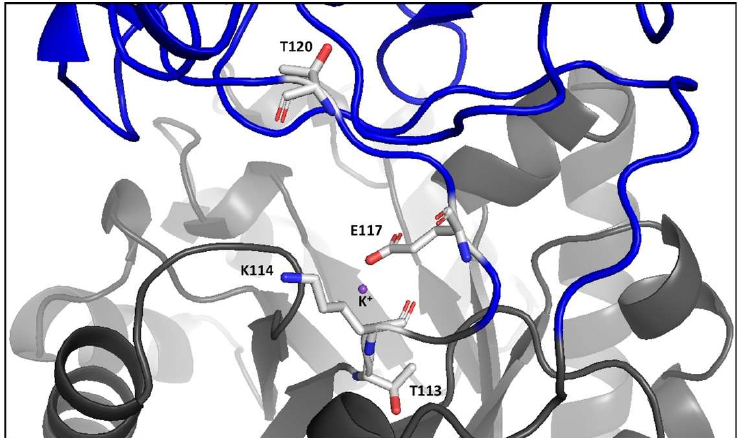
Figure 1. Ribbon representation of the boundary region between domains A (gray) and B (blue) of WT-RMPK. According to Oria-Hernández et al. (2006) [16], short loop residues T113, K114, E117, and T120 co-evolve in a consensus sequence in the family of the K + -dependent PKs in 80% of the 121 sequences; whereas L113, Q114, K117 and (L, V, I) 120 co-evolve in the K + -independent PKs in 77% of the 106 sequences. Residues of RMPK are illustrated in sticks and K + in purple. The figure was constructed with PDB 1A49, subunit A. This work focuses on understanding the individual and combined roles of highly conserved residues forming part of a ’signature’ sequence of K + -independent PKs. To this end, the residues at these positions in the K + -dependent sequence of WT-RMPK (T113/K114/E117/T120) were gradually replaced by those from K + -independent PKs (L113/Q114/K117/L120). It was the quadruple mutant T113L/K114Q/E117K/T120L would confer K + -independence and would exhibit activities like those of WT-RMPK with K + . However, results indicate that K + -independent activity increases with the addition of residues L113 and Q114 to K117, obtaining half of the ex- pected activity; but the addition of residue L120 leads to a nearly inactive enzyme. The